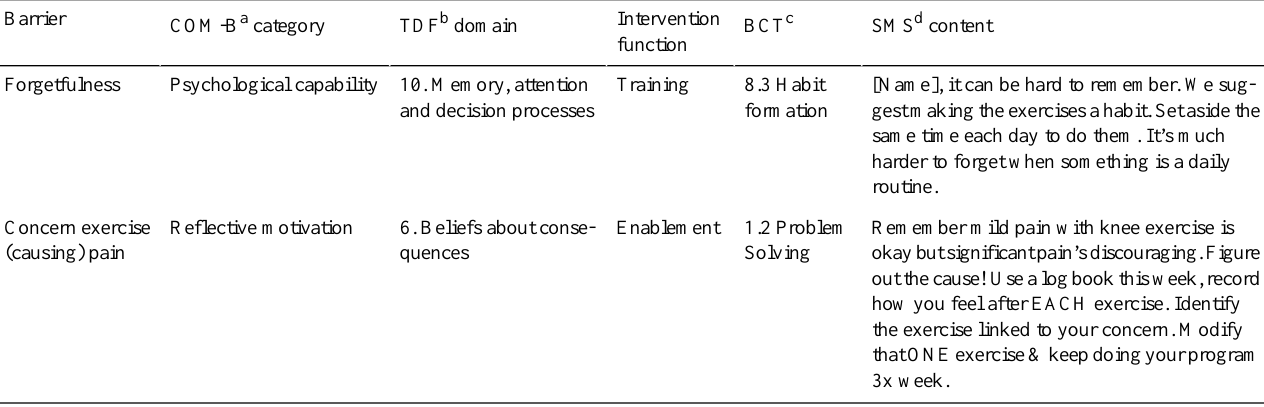
Table 2. Example mapping of barrier behavior change technique messages following the behavior change wheel framework.